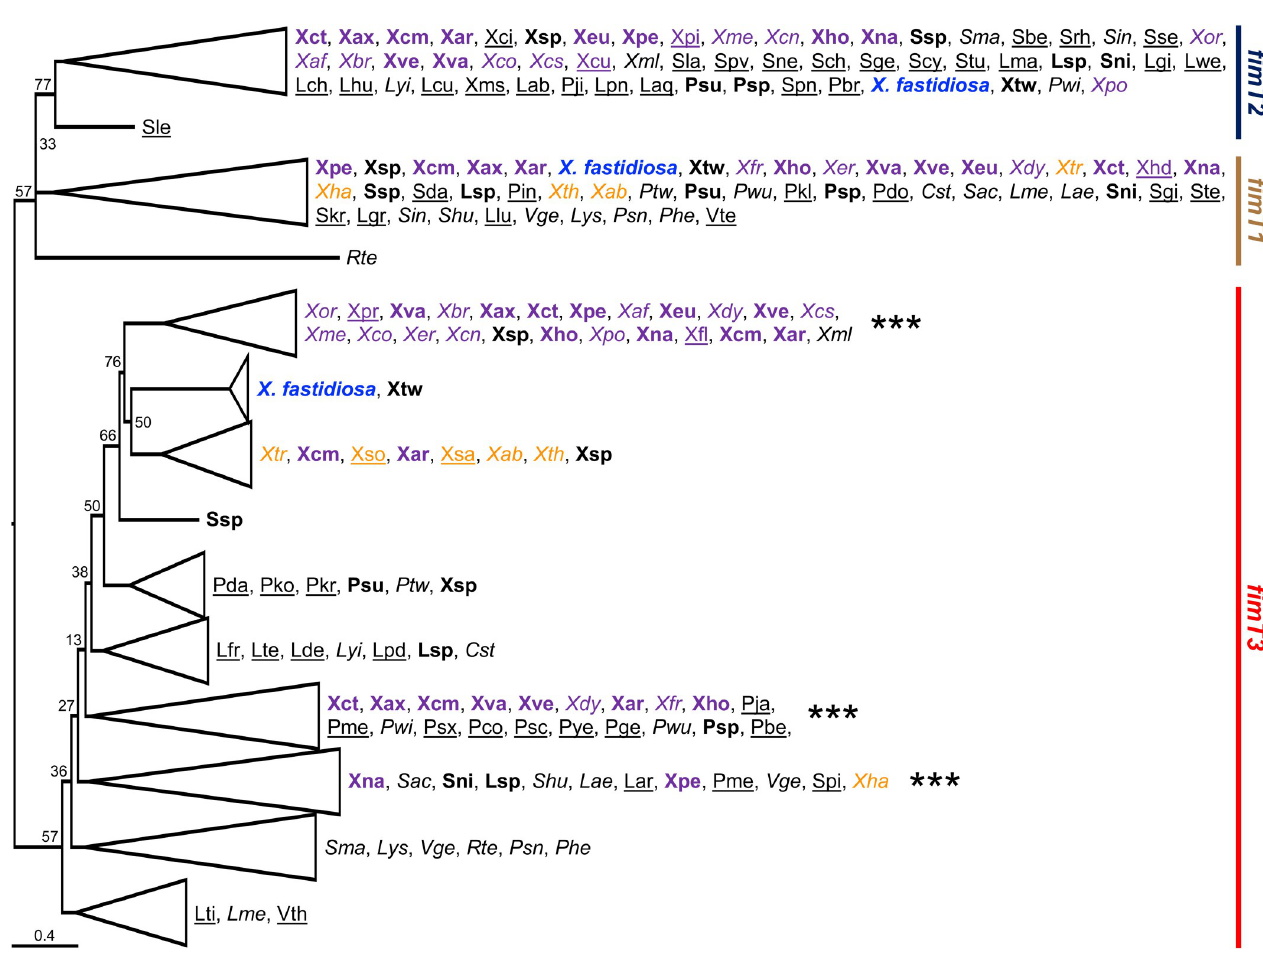
Fig 4. Phylogenetic tree based on nucleotide sequences of the three fimT paralogs from Xanthomonadaceae bacterial strains with whole-genome sequences available. The phylogenetic tree was built using the Maximum-likelihood method and visualized using FigTree. Branches with bootstrap values below 70% were collapsed, except where indicated. This was performed to keep conciseness of the figure while indicating the different clusters for fimT1 , fimT2 and fimT3 . X . fastidiosa is highlighted in blue within the tree. When known, clade I Xanthomonas spp. are highlighted in orange, and clade II Xanthomonas spp. are highlighted in purple. Bacterial species encoding all three fimT paralogs are indicated in bold, while those encoding two paralogs are shown in italics and those encoding only one paralog are underlined within the tree. The order of appearance of bacterial species in collapsed branches follows the original order of appearance within the tree. For representation purposes, branches are highlighted by color according to each fimT paralog. Brown: fimT1 ; Dark blue: fimT2 ; Red: fimT3 . ��� Indicates clusters within the fimT3 clade which contain few FimT3 sequences with no GRxR motif (see S5 Table and S14 Fig). Abbreviations are the following. Coralloluteibacterium : Cst– C . stylophorae . Luteimonas : Lab– L . abyssi ; Lae– L . aestuarii ; Laq– L . aquatica ; Lar– L . arsenica